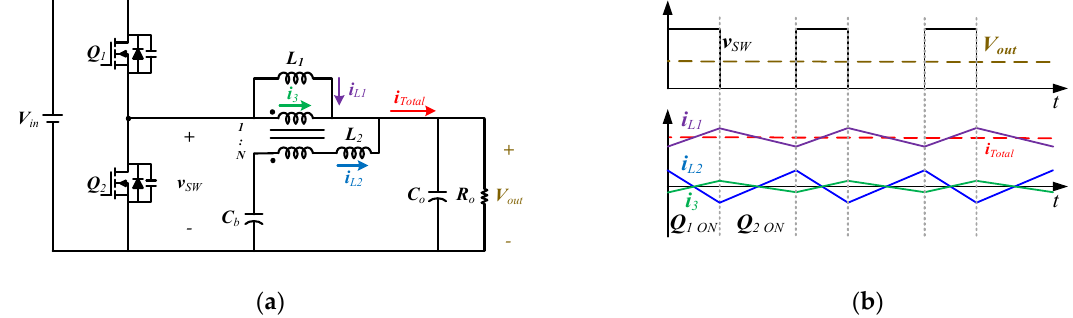
Figure 1. Ripple current cancellation circuit: ( a ) circuit architecture diagram; ( b ) operation sequence diagram.